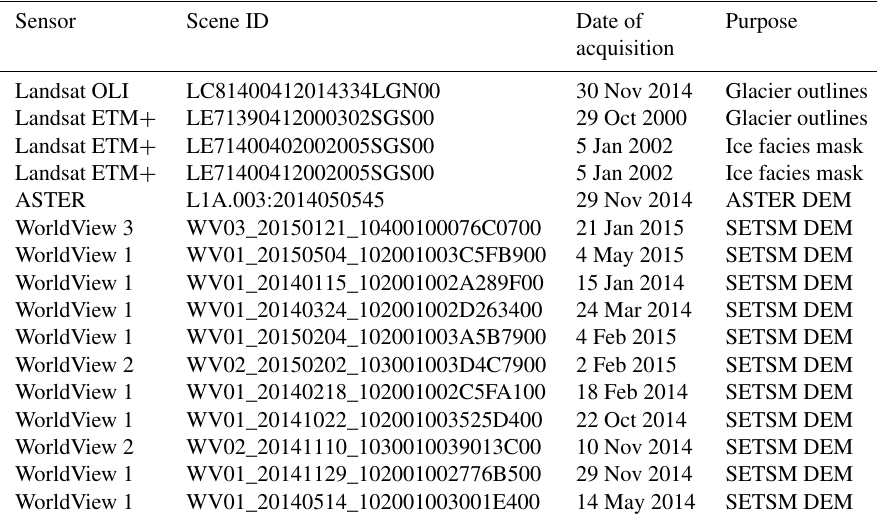
Table 1. Scenes used in glacier outline delineation, ASTER DEM generation, SRTM ice facies mask generation and by the Polar Geospatial Center in the generation of SETSM